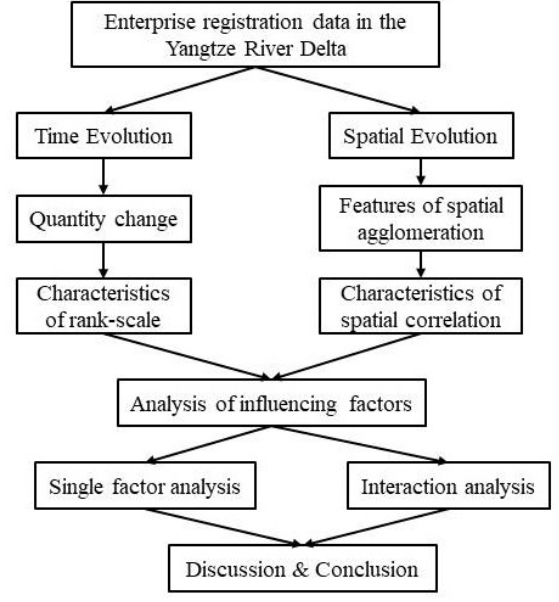
Figure 1. Technology roadmap for this study.